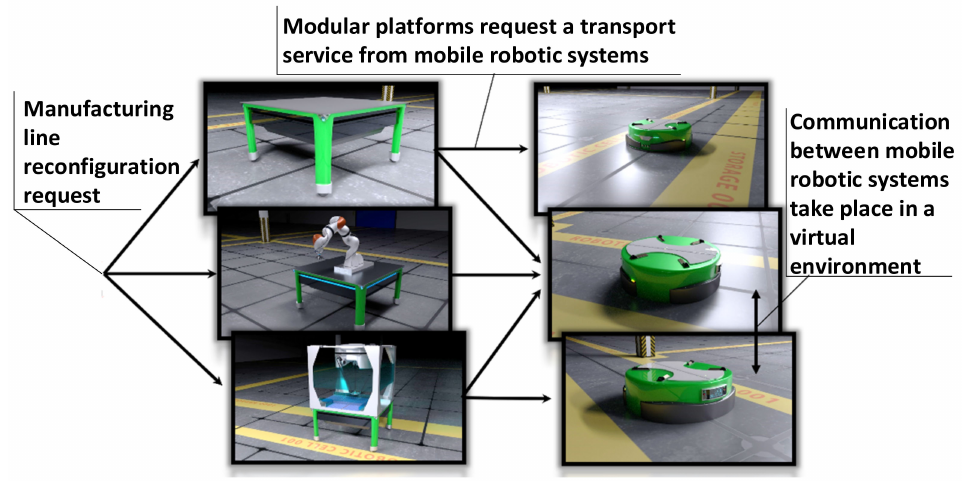
Figure 1. Block diagram of the proposed Mobile Robotic